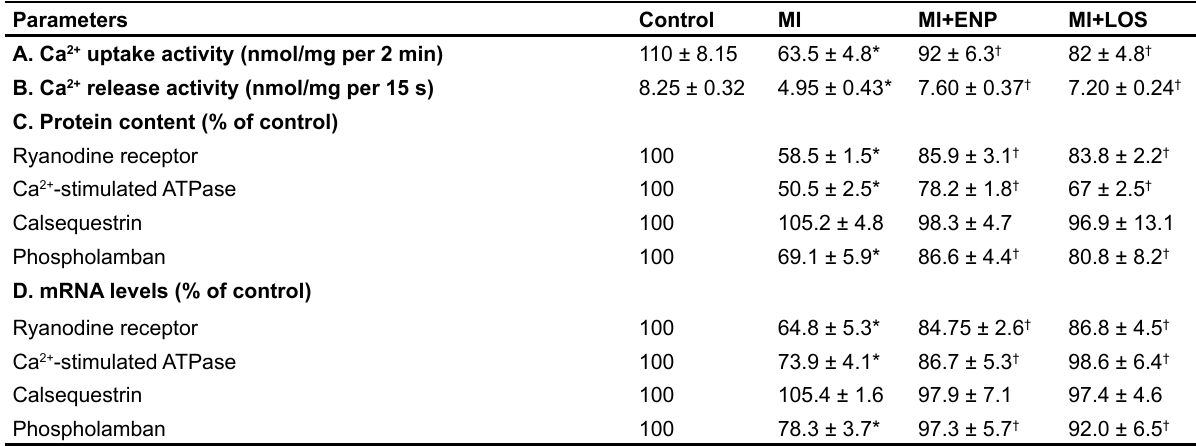
Values are mean ± SE of 7 animals in each group. Data are based on the analysis of the information in table 5 and figures 3 and 4 in our papers Shao et al. Am J Physiol Circ Physiol. 2005;288:H1674-82 [113] and Guo et al. Mol Cell Biochem. 2003;254:163-72 [118]. * P < 0.05 compared with control; † P < 0.05 compared with MI